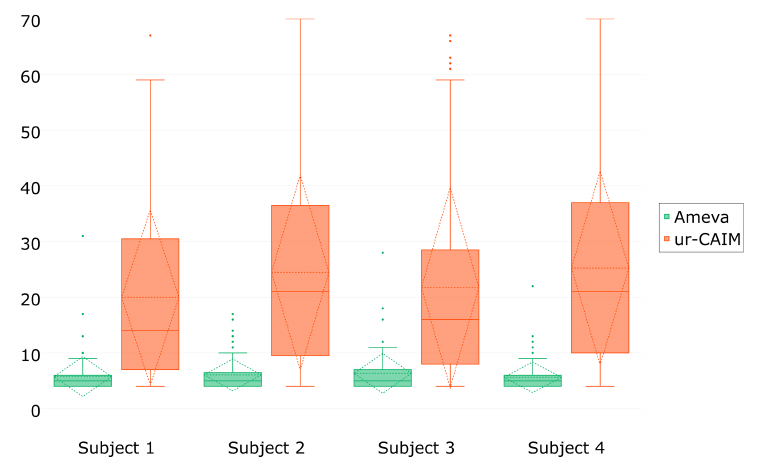
Figure 4. Box plot representation for discretization (number of cut